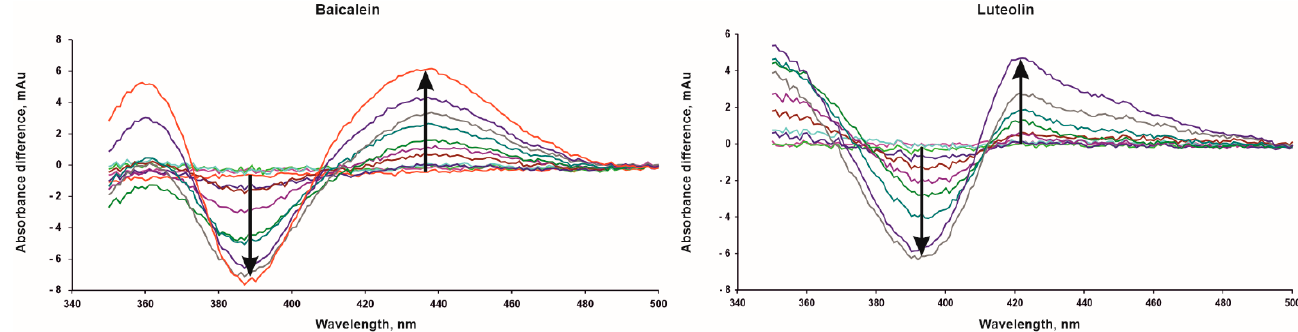
Figure 3. Difference spectra of CYP51A1 in the presence of lanosterol after addition of baicalein (up to 30 µ M) and luteolin (up to 15 µ M). The arrows indicate the direction of the spectral changes with increasing ligand concentration.